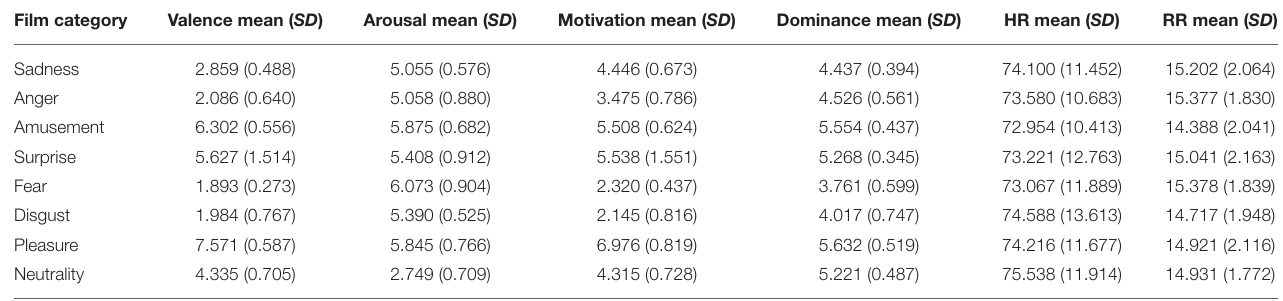
TABLE 2 | Self-report ratings and psychophysiological responses per category, mean ( SD ). Film category